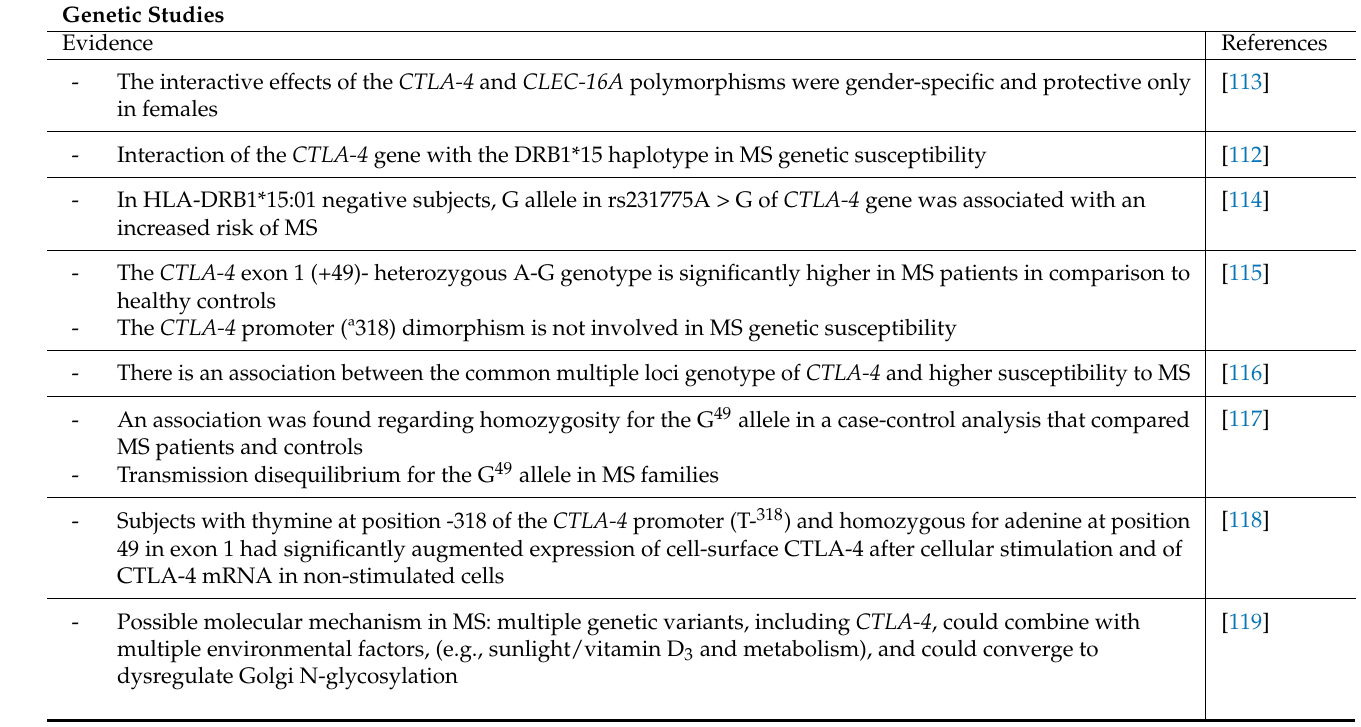
Table 3. Schematic overview of the most important evidence from the clinical genetic studies investigating the role of CTLA-4 in